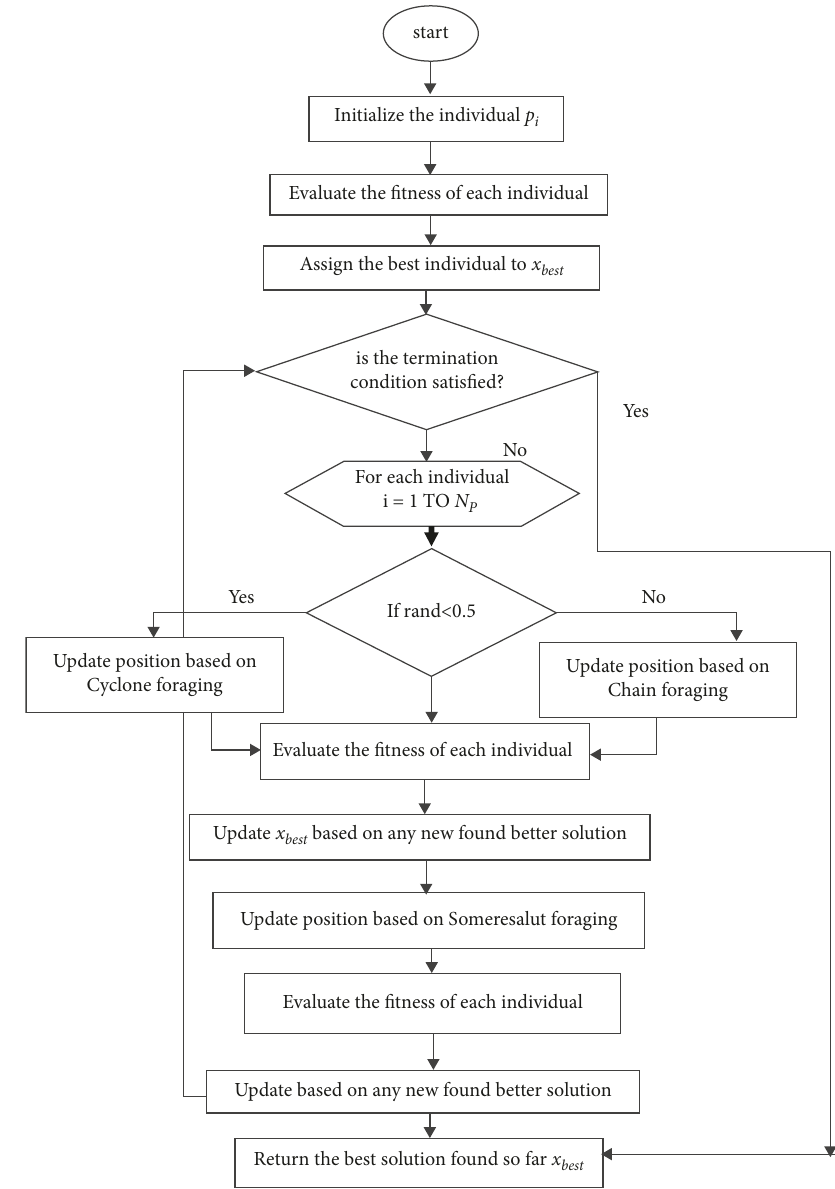
Figure 2: Flowchart of the MRFO-based clustering